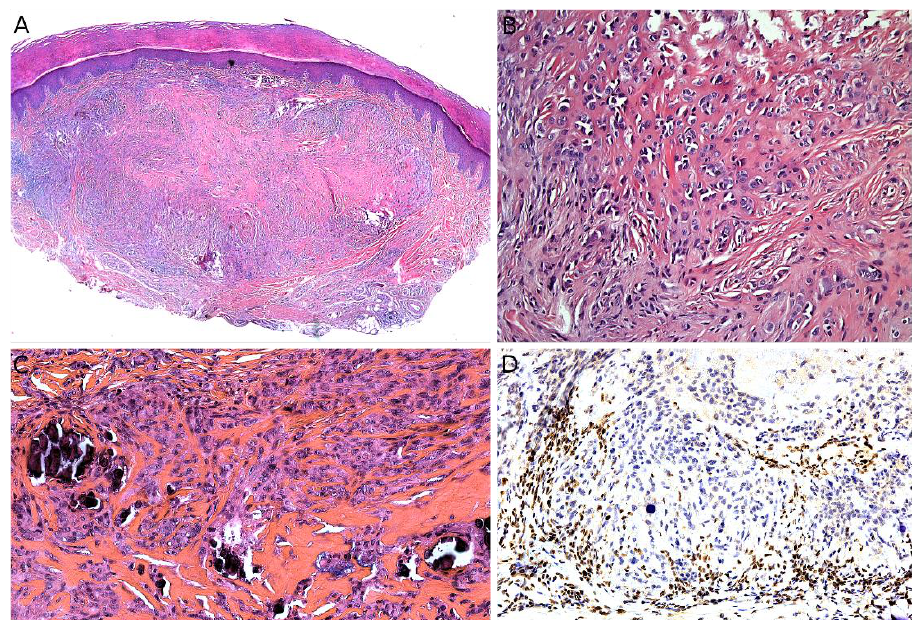
Figure 15. Epithelioid sarcoma: ( A ) Dermal nodule with central necrosis in an acral skin (note the thick stratum corneum) (×25); ( B ) epithelioid cells in a dense fibrous stroma (×100); ( C ) epithelioid thick stratum corneum) ( × 25); ( B ) epithelioid cells in a dense fibrous stroma ( × 100); ( C ) epithelioid cells and calcifications (×100); ( D ) loss of INI1 in the tumor cells (×100). cells and calcifications ( × 100); ( D ) loss of INI1 in the tumor cells ( ×